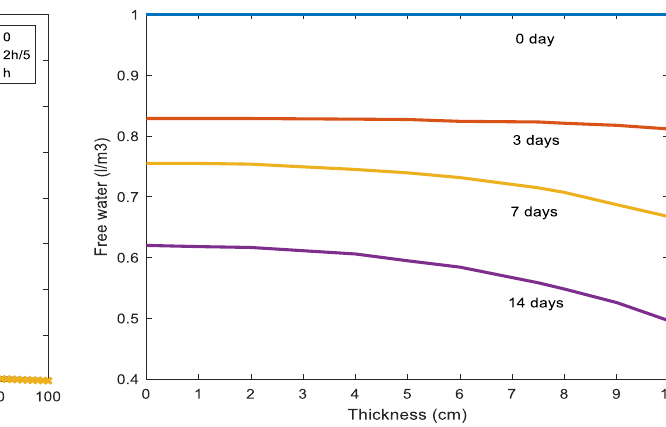
Figure 8: Free water evolution at di ff erent points.